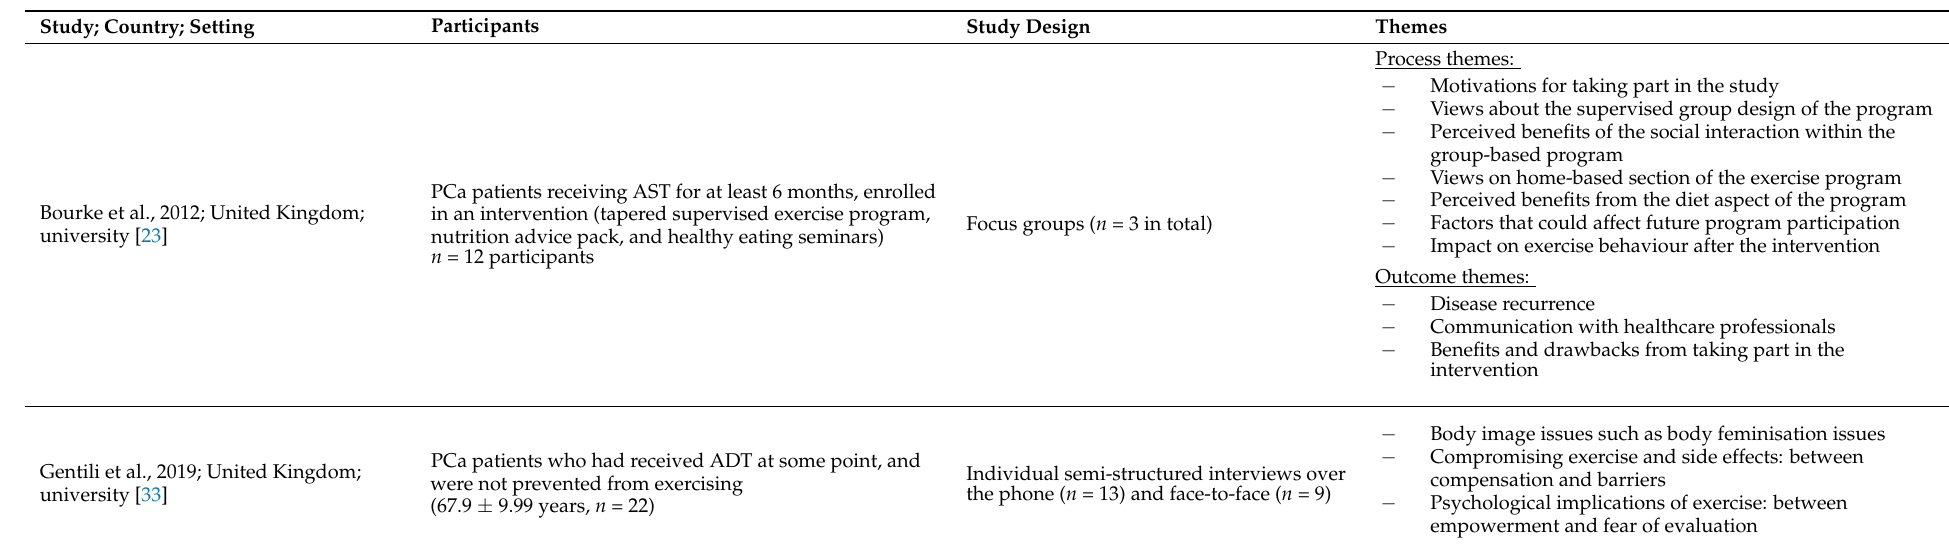
Table 2. Qualitative Studies Summary ( n = 6